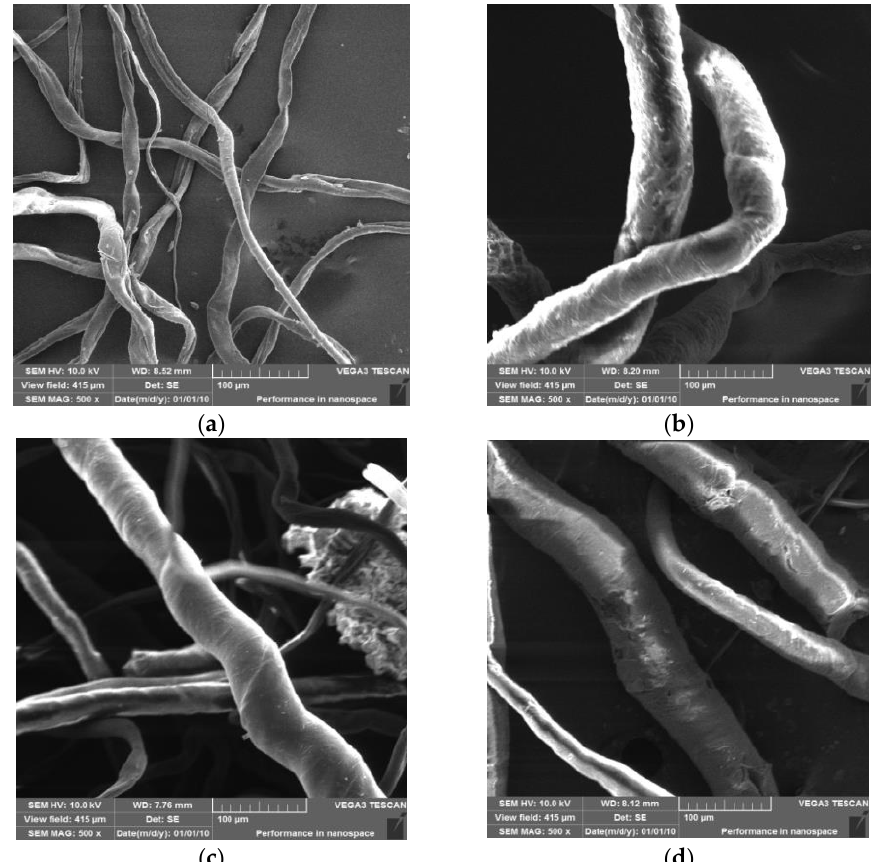
Figure 4. SEM photographs of original cotton linter ( a ), CLF-g-GMA ( b ), CLF-g-GMA-PEHA ( c ) and QCLF ( d ).